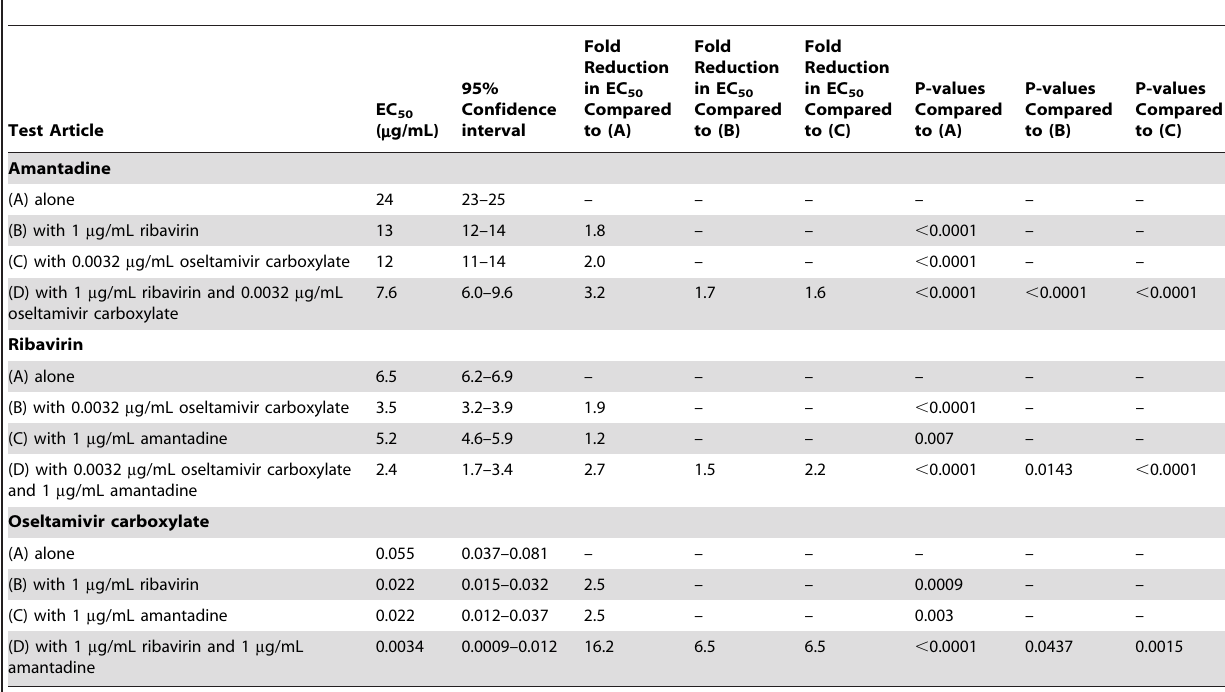
Table 2. The 50% effective concentration (EC 50 ) of amantadine, ribavirin, and oseltamivir carboxylate as single agents and in double and triple combinations against 2009 H1N1 A/California/10/09 (CA10) as determined by Neutral Red assay.